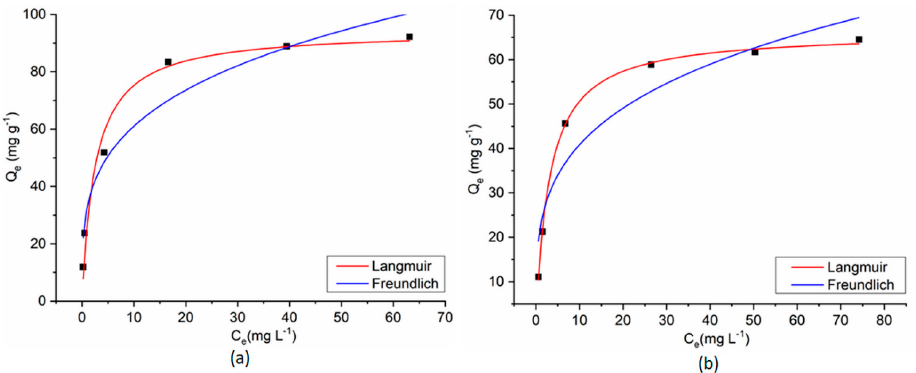
Figure 16. Langmuir and Freundlich fitting curves for MO adsorption onto CoFe 2 O 4 ( a ) and CoFe 2 O 4 − Chit ( b ) from single component solution. The equilibrium isotherm parameters and the correlation coefficients (R 2 ) for the studied adsorption processes are presented in Table 1. For the Langmuir isotherm, a dimensionless separation factor (R L ) can be estimated with Equation (9):